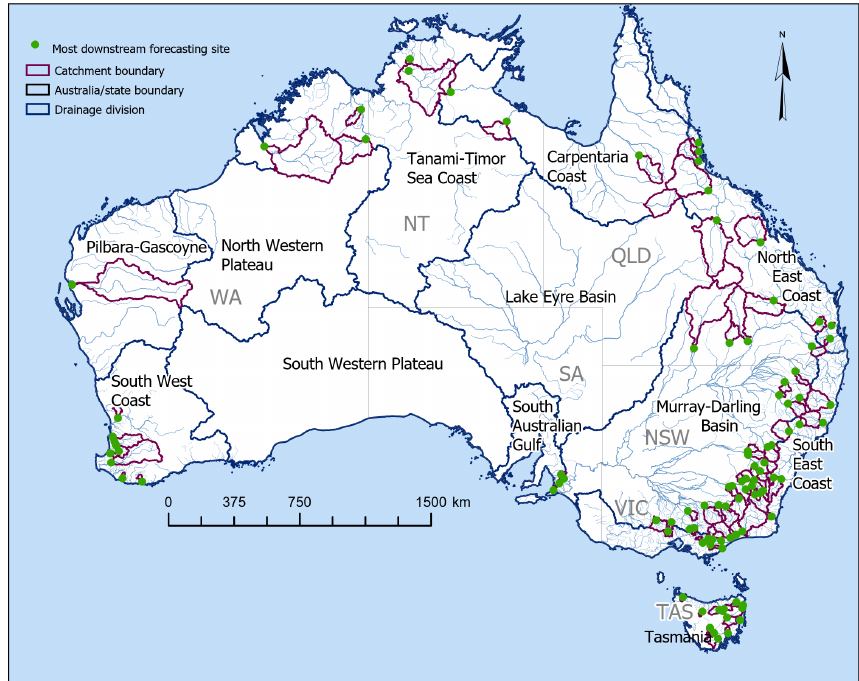
Figure 2. Map of Australia showing forecast locations, catchment boundaries, and drainage divisions. Table 3. Drainage divisions (see Fig. 2) and catchment